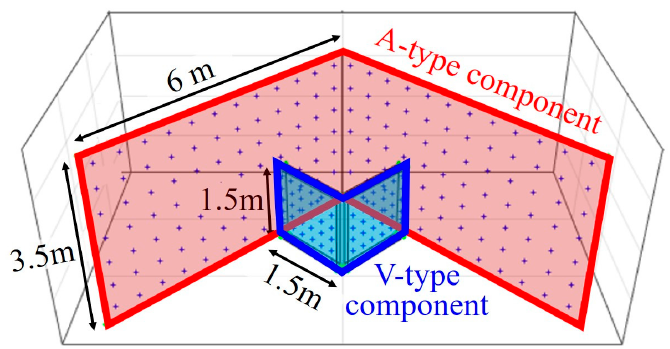
Figure 2. Designed AV-type test-bed for simulation